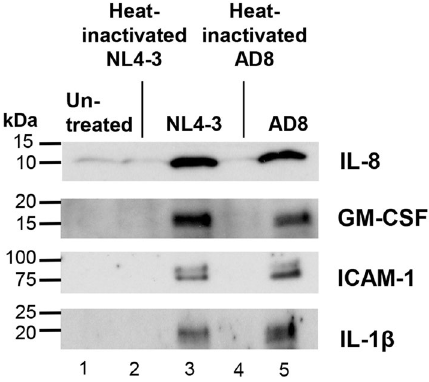
Figure 3. Western analysis of HIV-induced cytokine secretion by airway BC. BC were exposed to HIV or heat-inactivated HIV for 2 days. Culture supernatants were collected for assessment of cytokine release. Western analyses of IL-8, GM-CSF, IL-1β and ICAM-1 are shown. Lane 1—untreated BC; lane 2—heat-inactivated NL4- 3-treated BC; lane 3—NL4-3-treated BC; lane 4—heat-inactivated AD8-treated BC; lane 5—AD8-treated BC. The original images of full-length immunoblot for each cytokine was shown in Supplemental Fig.